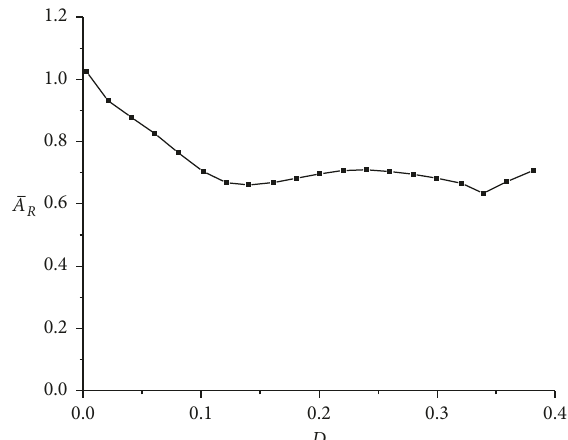
Figure 7: Variation curve of the average amplitude attenuation ratio of ground displacement with